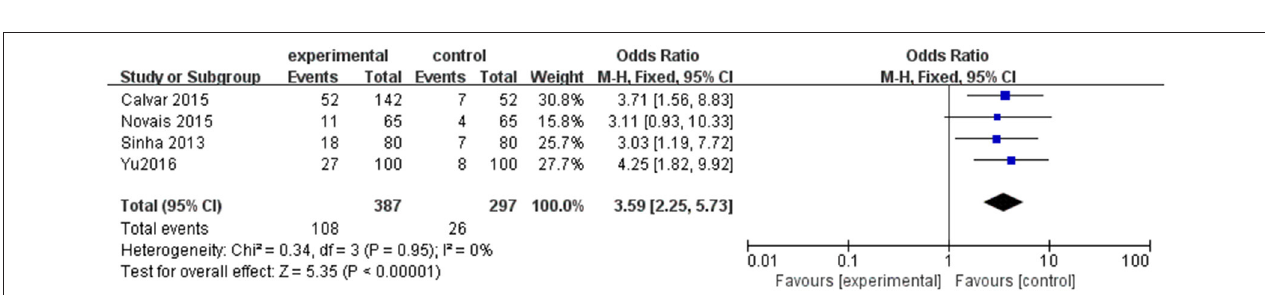
FIGURE 3 | Forest plot of the prevalence of SCH in women with and without PCOS. Details are given for events, number of included subjects, and odds ratio for each study as well as the overall events, subjects numbers, and odds ratio given in bold in the “Total” row. CI, confidence interval; df, degrees of freedom; M-H, Mantel-Haenszel; SCH, subclinical hypothyroidism.